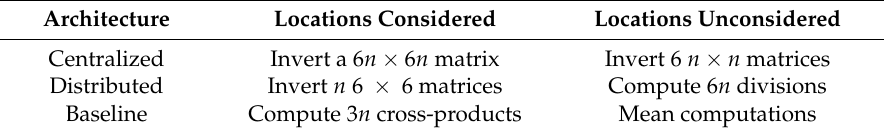
Figure 8. Relative computational time. Table 3. Most time consuming operation for each architecture.